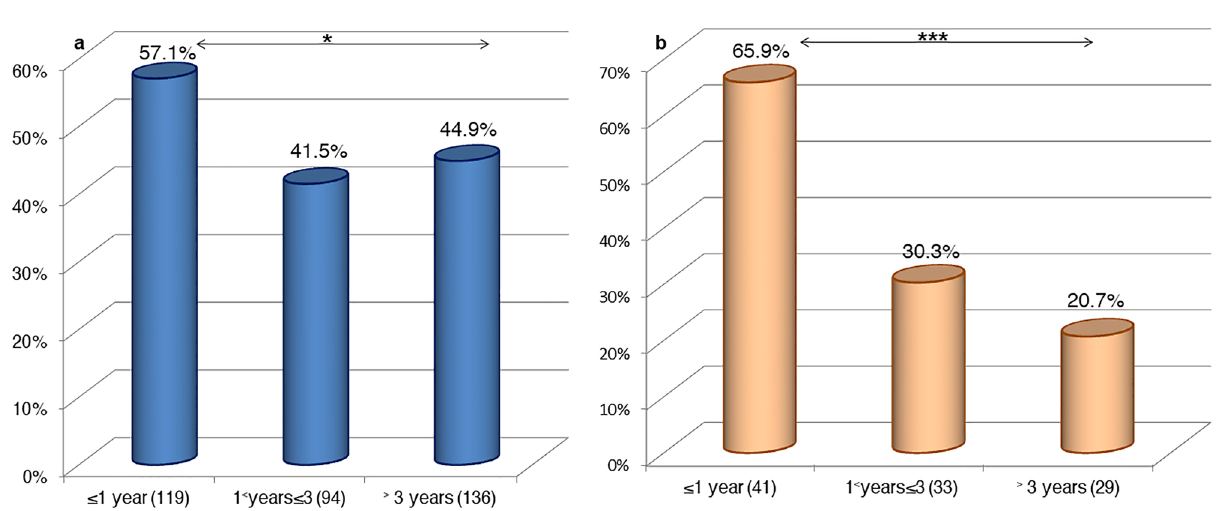
Figure 4. BTV viropositivity rates variation by age in sheep and goats during March 2018–July 2021 in Morocco. ( a ) In sheep. ( b ) In goats (in brackets, the number of samples screened). The statistical significance between rates is indicated as *P < 0.05 or ***P <